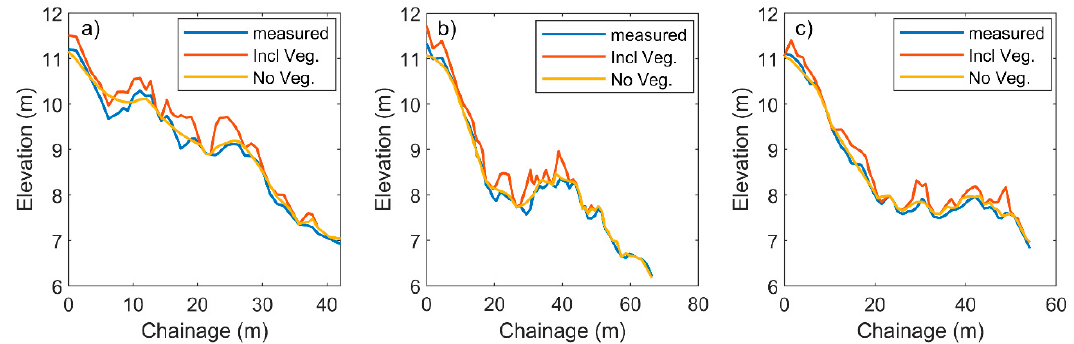
Figure 3. A map showing the four overlapping flight areas used to cover the dune system and also the location of the three transects used to test vegetation removal method.